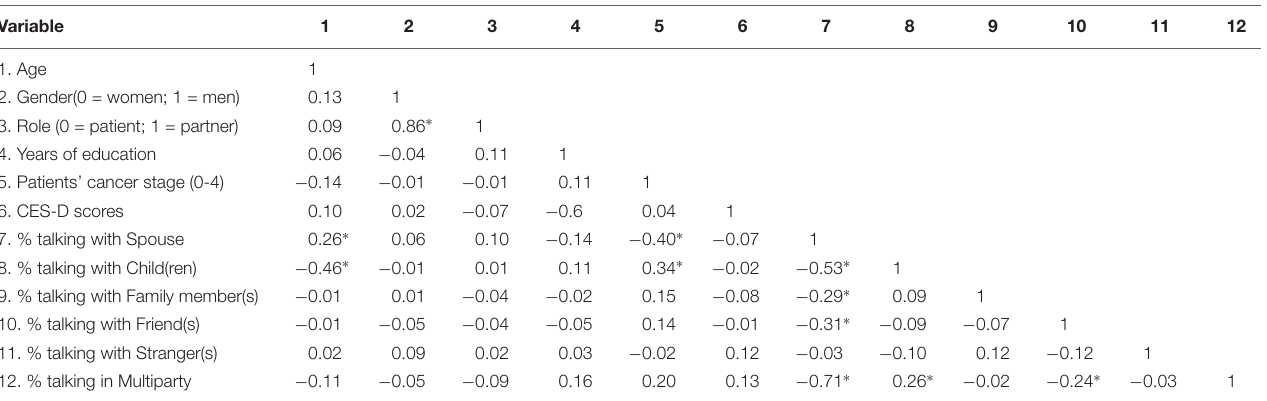
TABLE 1 | Intercorrelations between participants’ characteristics and percentage of time spent with different interlocutors.